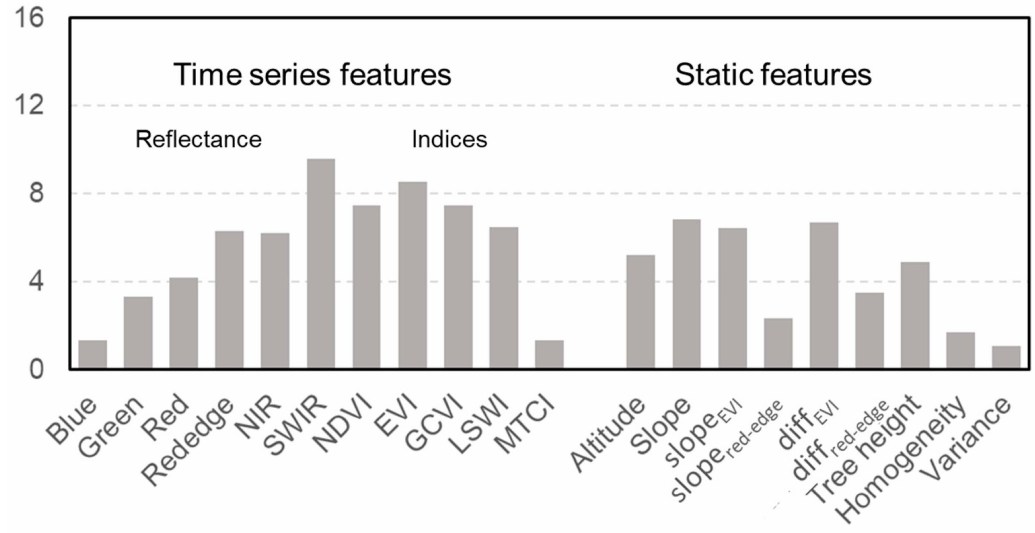
Figure 8. Relative importance for input